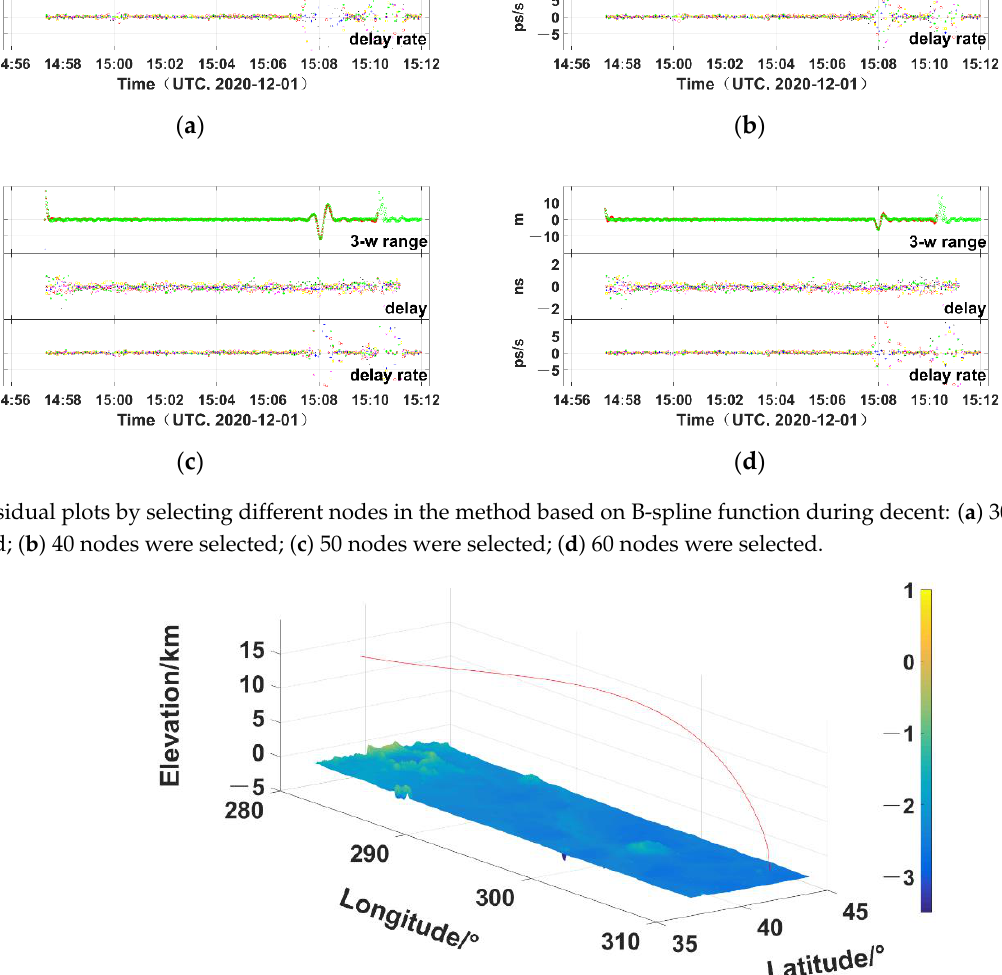
Figure 1. Residual plots by selecting different nodes in the method based on B-spline function during decent: ( a ) 30 nodes were selected; ( b ) 40 nodes were selected; ( c ) 50 nodes were selected; ( d ) 60 nodes were selected.